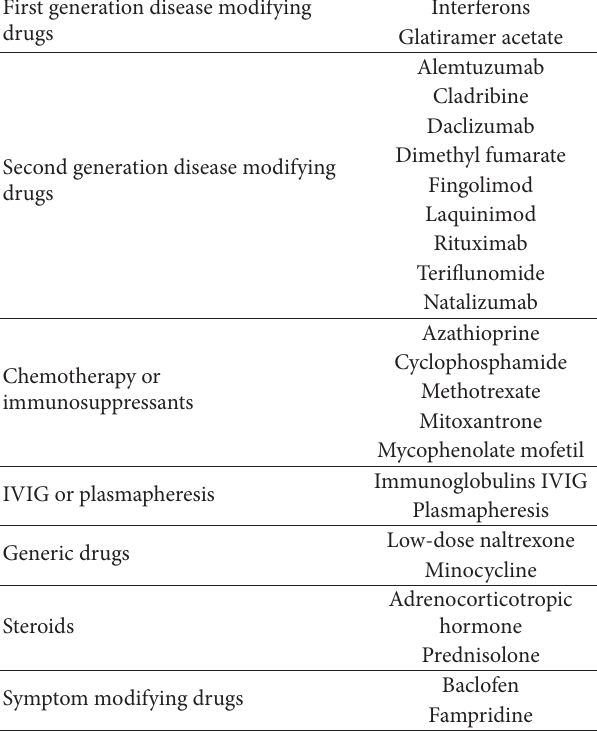
Table 2: Classification of MS medication